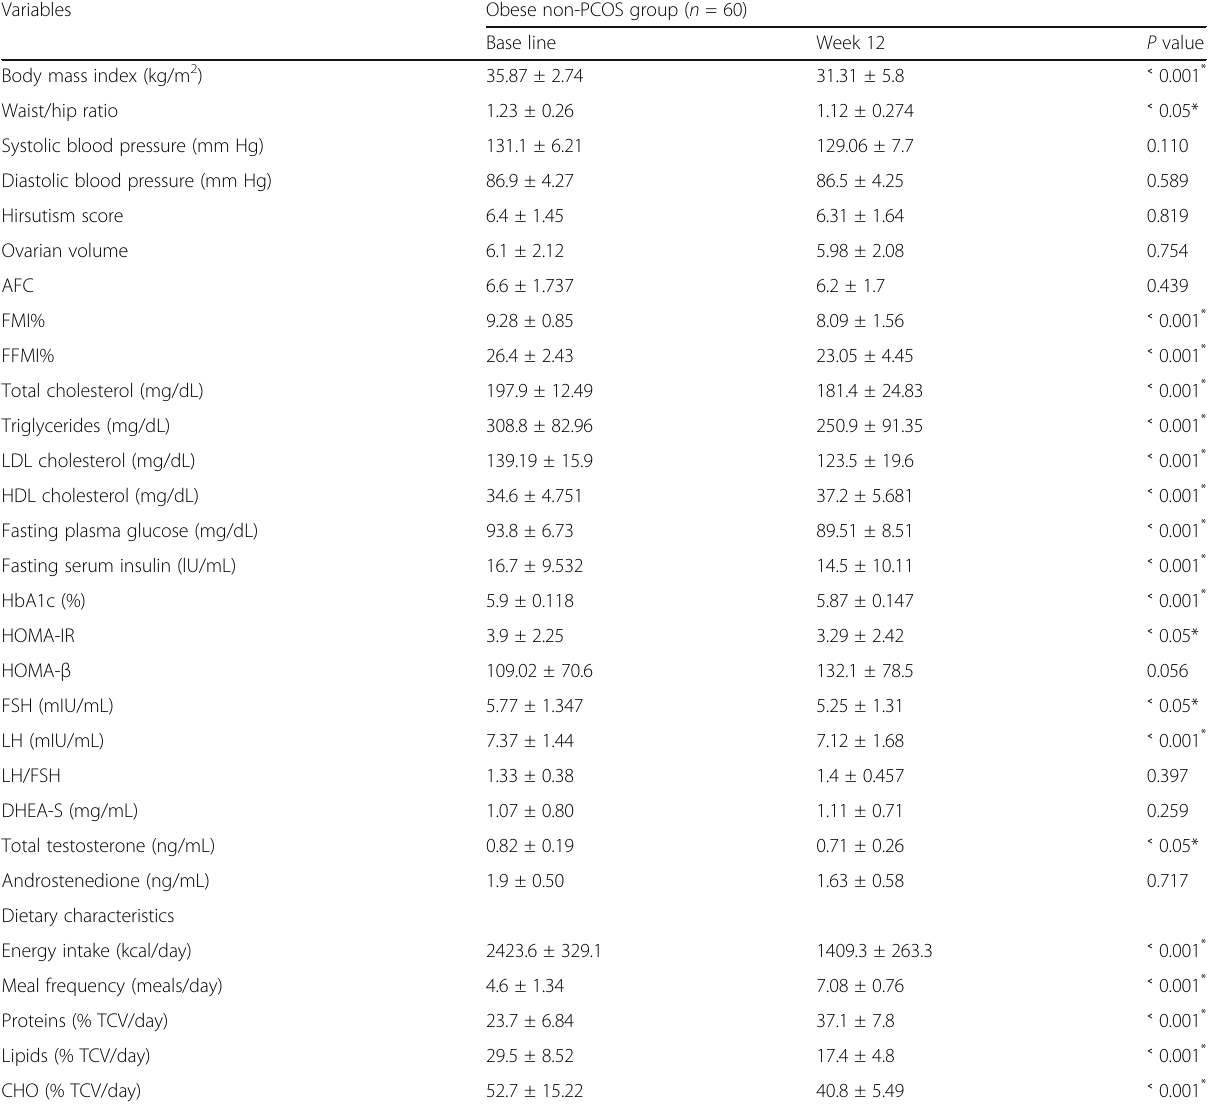
Table 2 The impact of weight loss on clinical, anthropometric, and laboratory characteristics of obese non-PCOS group